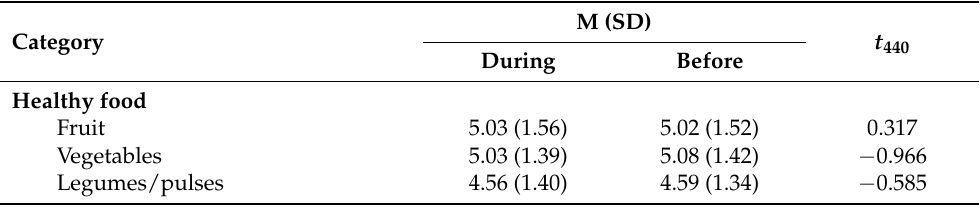
Table 3. A comparison of change in food consumption type during and prior to the first COVID-19 lockdown period among Chinese in China by using a paired t